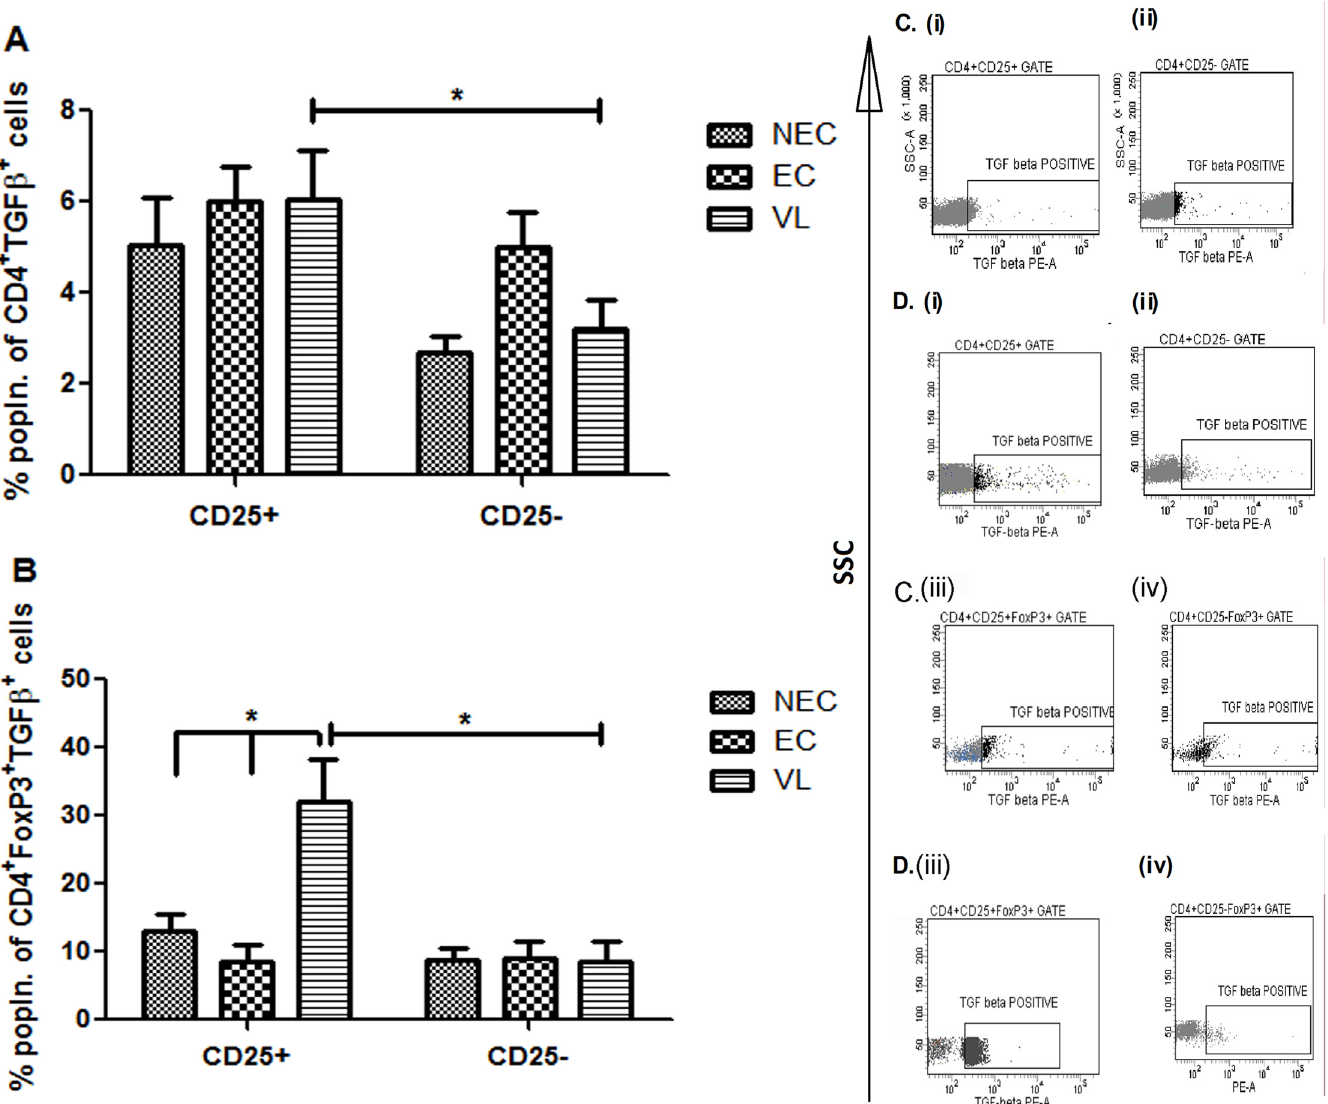
Fig 7. Identification of cellular sources of TGF β in PBMCs of VL patients (n = 10), ECs (n = 5) and NECs (n = 5). Total PBMCs were freshly cultured in the presence of PMA (50 ng/ μ l), ionomycin (1 μ g/ μ l) for 2 hrs and for additional 1 hr in presence of brefeldin A (10 μ g/ μ l) before staining. (A) Percentages of CD25+ and CD25 − cells among CD4+TGF β + cells. (B) Percentages of CD25+ and CD25 − cells among CD4+FoxP3+TGF β + cells. Data are represented as mean ± SE. P values were calculated using Wilcoxon matched pairs signed rank test for paired samples; P < 0.05 was considered significant. (C), (i)-(iv) Data showing one representative healthy control. (D), (i)-(iv) Data showing one representative active VL